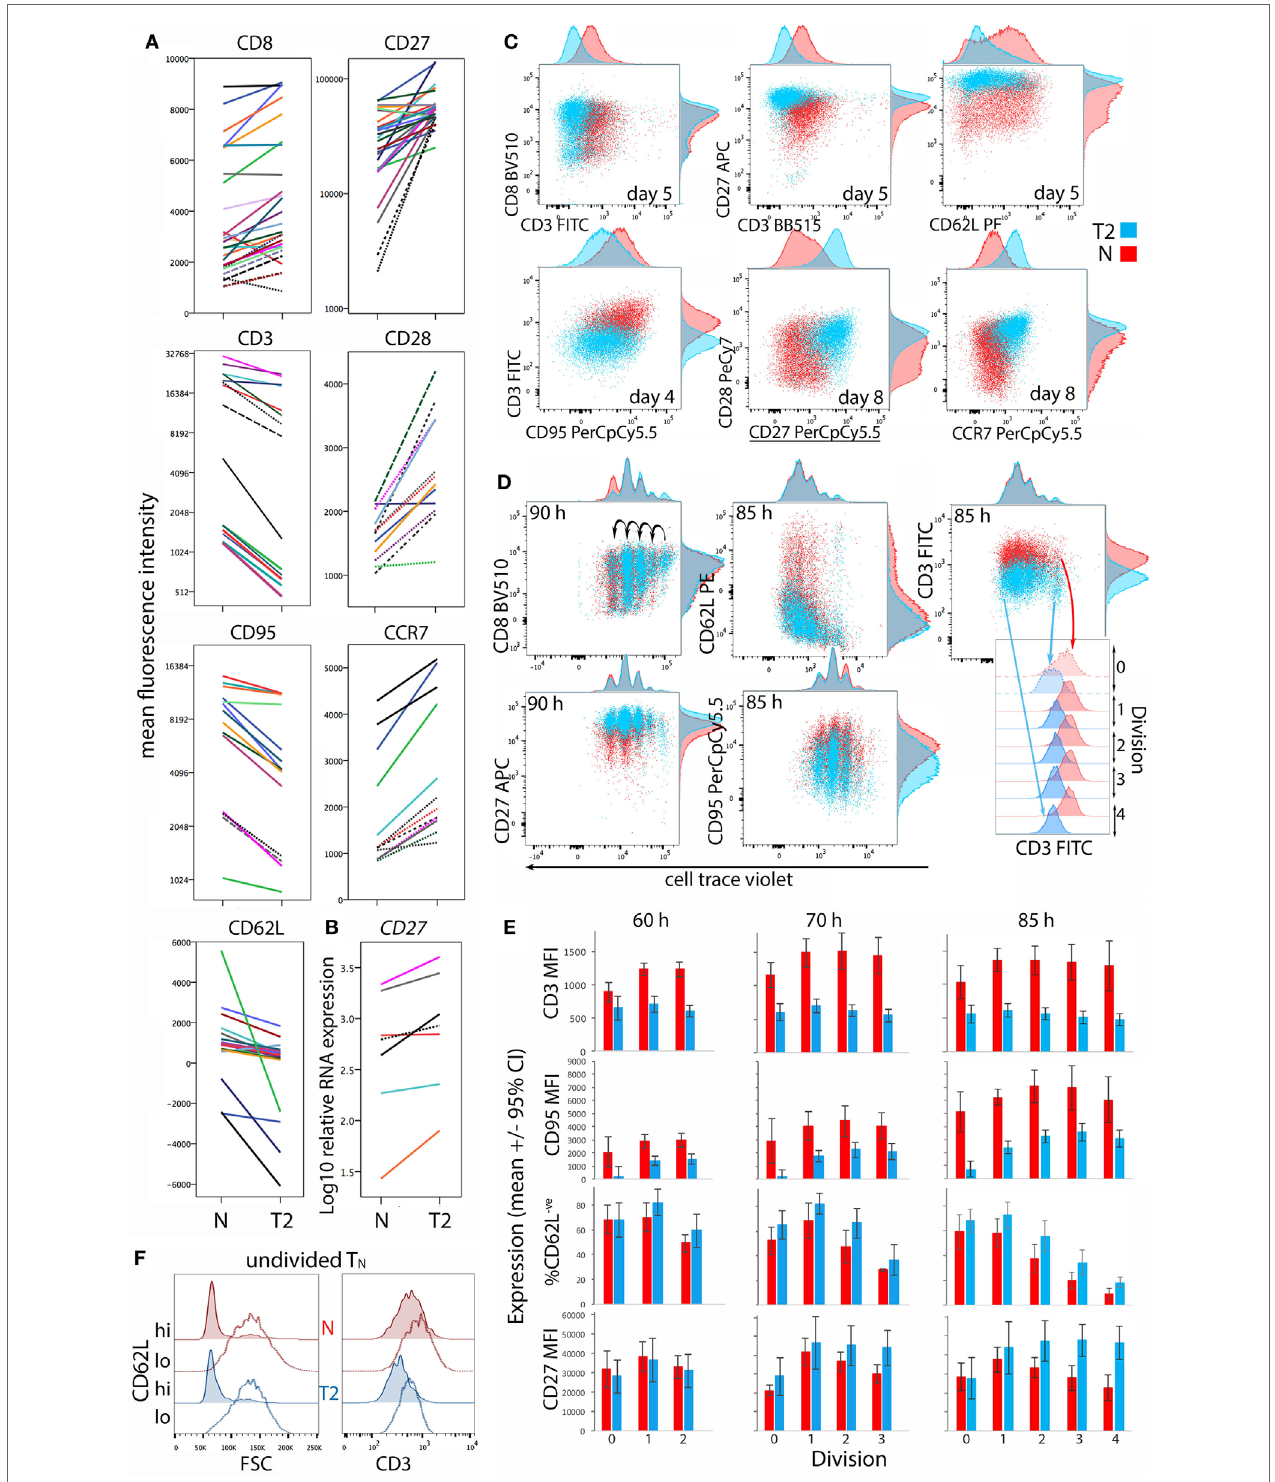
FigUre 4 | Differentiation phenotype of CD8 + T N activated in neutral or type-2 (T2) conditions. CD8 + T N were stimulated as described in Figures 2 and 3 , and analyzed 5–8 days later (a–c) , or were stained with cell trace violet (CTV) and analyzed 60–85 h later (D–F) . (a) Lines join samples from the same donor and time-point primed in neutral and T2 conditions; dashed lines indicate samples assessed following restimulation. (b) CD27 mRNA expression 5 days after activation, presented as in (a) . (c,D) Representative overlay plots compare cell surface marker expression for neutral (red) and T2 (blue)-primed cells. (e) Surface receptor expression according to division number. Mean and 95% confidence interval for cells from four donors and three time-points are shown. (F) Profiles of neutral versus T2-primed undivided CD62L hi and CD62L − cells. Results are shown for one of four donors at 60